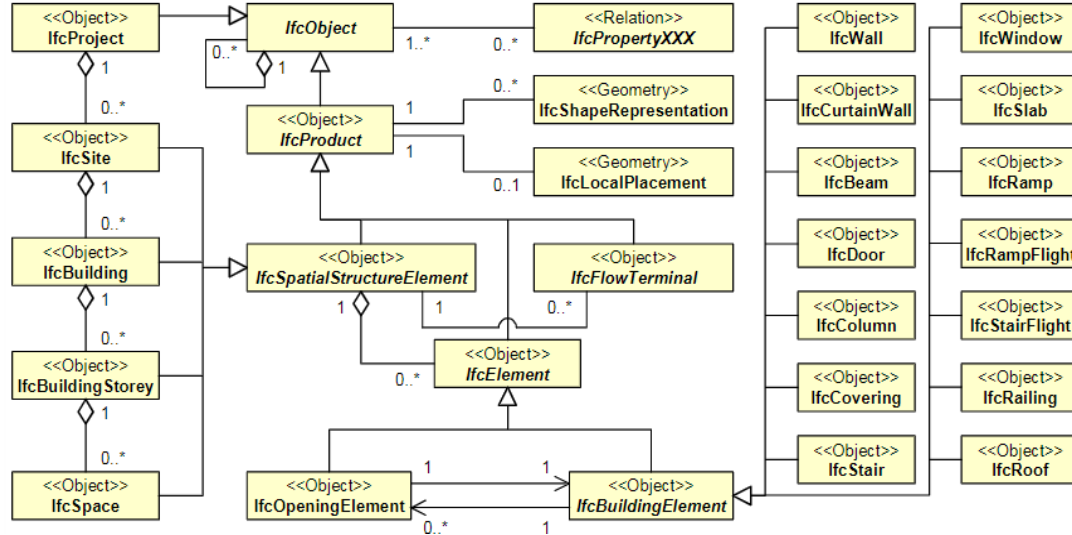
Figure 2. UML Diagram of some of the IFC Entities that can be extracted and used for CityGML model (Floros et al., 2017) Based on ISO